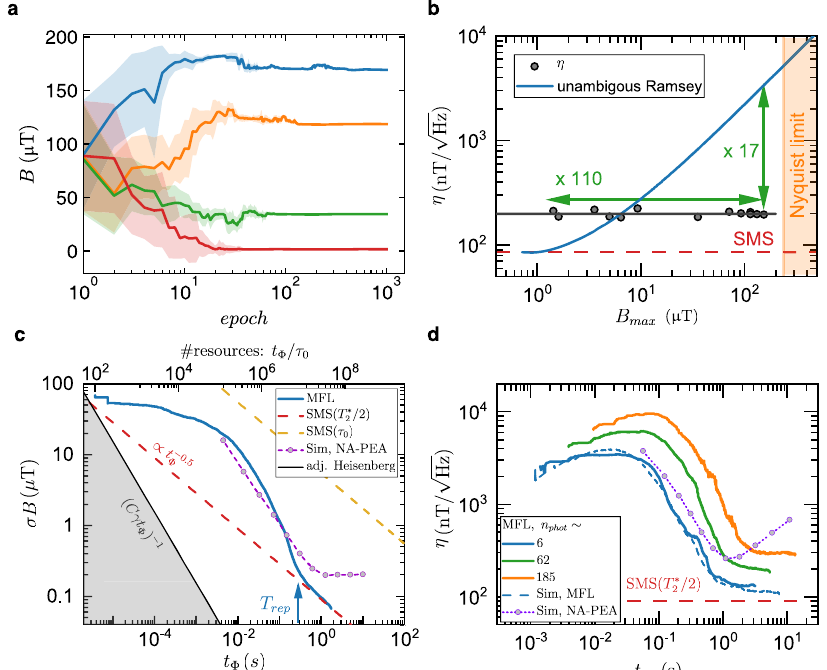
Fig. 2 DC magnetic fi eld estimation. a Outcome of MFL for four runs and uncertainty ( σ B s.d., shaded regions) of the estimated magnetic fi eld with different applied B (1.8 μ T (red) to 169 μ T (blue)). b Sensitivity η for different applied magnetic fi elds B of an unambiguous Ramsey experiment with fi xed τ set by the dynamic range [ − B max , B max ] is shown in blue, up to τ ¼ T (cid:3) the standard measurement sensitivity (SMS, red dashed line). The average photon number is n phot ~ 65 for all MFL runs. c Magnetic fi eld uncertainty σ B versus the accumulated phase evolution time t Φ for an on average number n phot ~ 9 photons per epoch. A NA-PEA simulation (lilac, optimized parameters G = 10, F = 1, n phot = 180) with similar readout conditions is plotted (described in the main text). The black line represents the Heisenberg uncertainty limit for a single experiment with phase evolution t Φ and no decoherence with identical readout ef fi ciency to other datasets, the orange dashed line is the theoretical uncertainty of an unambiguous Ramsey experiment repeated at τ = τ 0 realizing a dynamic range [ − B max , B max ]. d The magnetic fi eld sensitivity η versus the accumulated running time including all experimental overheads t tot for MFL runs with several selected average photon numbers. The effective sensitivity η eff` > η , which considers the noisy averaged readout, is optimized at an intermediate photon number. Dashed lines represent simulation data for MFL an NA-PEA, respectively. Deteriorating sensitivity for a longer running time in NA-PEA is due to phase evolution times well beyond T (cid:3) sensor application. The MFL data in b – d represents averaged runs (~50 repetitions per trace or data point) with the same parameters and applied magnetic fi eld. In a , c , d the allowed fi eld range in the initial prior is 0 ; B max ¼ 238